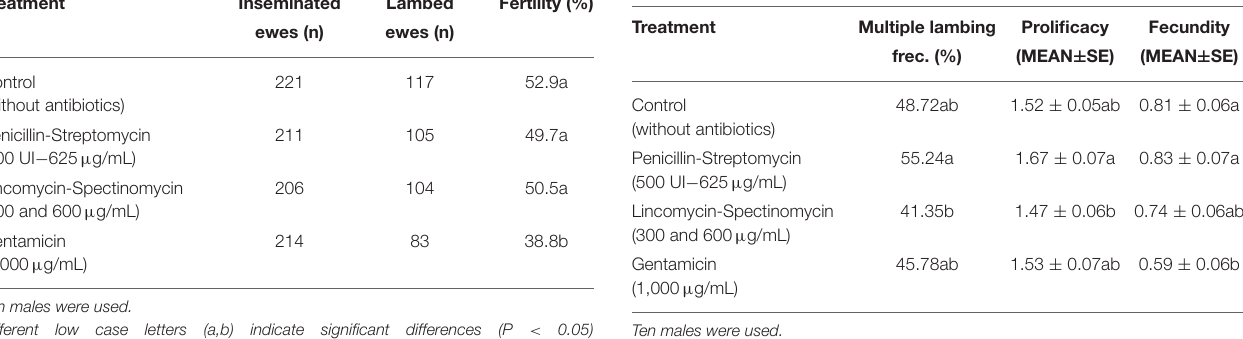
TABLE 2 | Multiple lambing frequency (%), prolificacy (lambs/lambed ewe), and fecundity results (lambs/inseminated ewes) by treatment as follows: Control (without antibiotics), Penicillin-Streptomycin; with Penicillin (500 UI) and Streptomycin to a final concentration of 625 µ g/mL; Lincomycin-Spectinomycin to